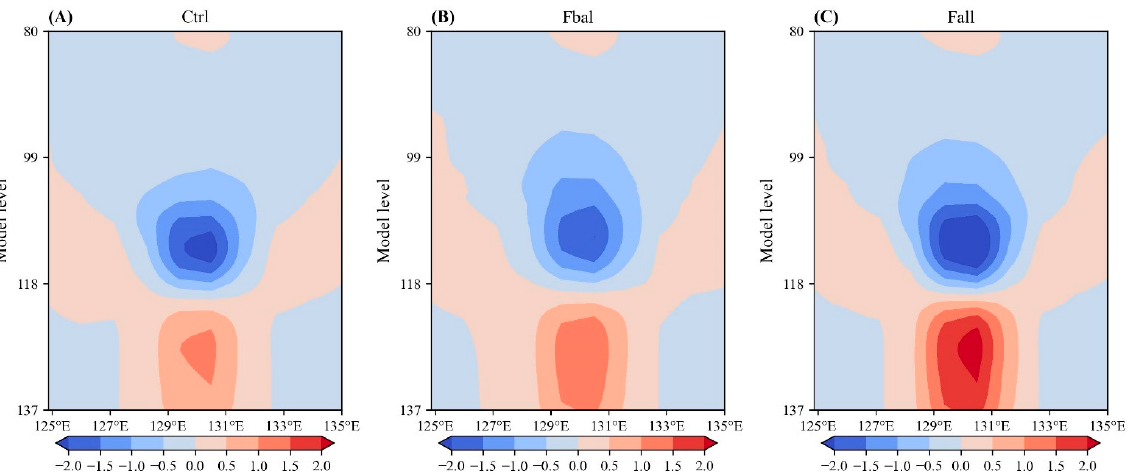
Figure 5. Zonal cross ‐ section of vorticity analysis increment in the model level 80–137 at 15 ° N val ‐ id on 19 October 2020, 0900 UTC. (A), (B) and (C) correspond to the “ctrl”, “fbal” and “fall” exper ‐ iments, respectively. Unit: 10 (cid:2879)(cid:2874) s − 1